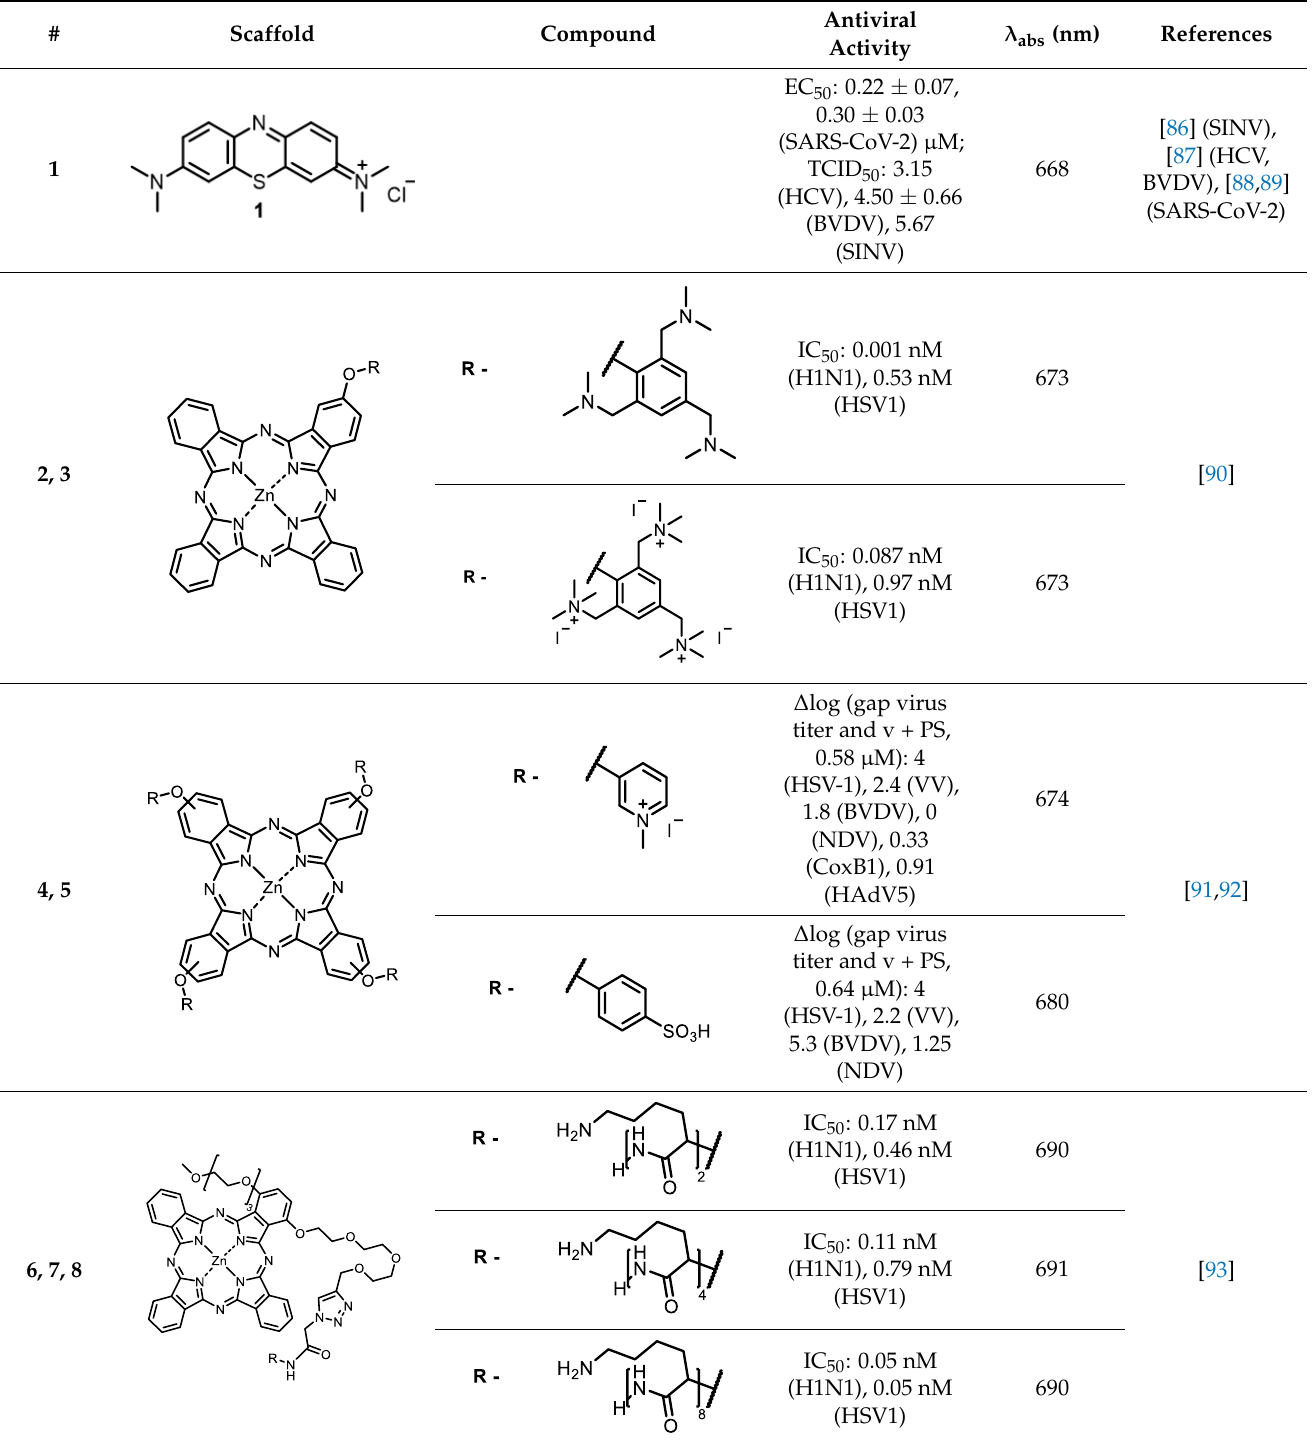
Table 1. Antiviral NIR photosensitizers.